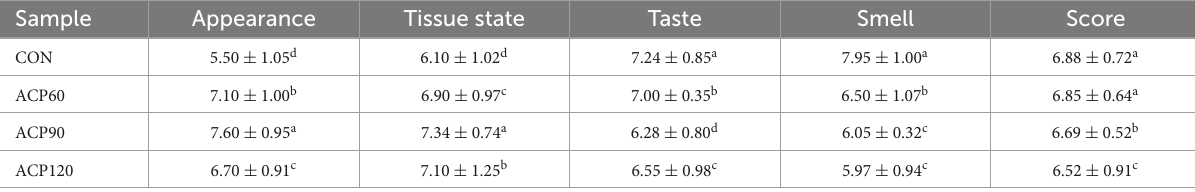
TABLE 2 Sensory evaluation of surimi gels without and with atmospheric cold plasma (ACP)